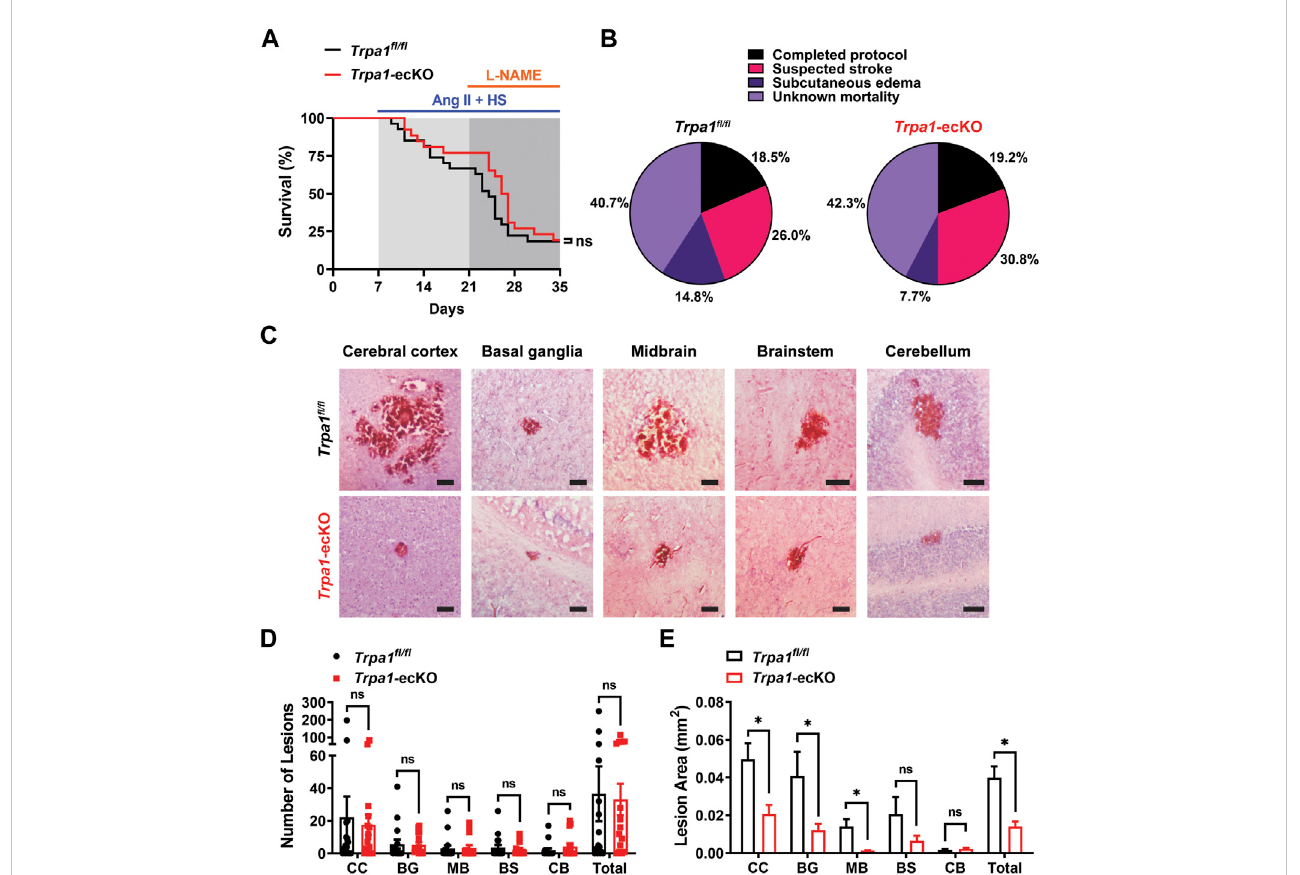
FIGURE 3 Endothelial cell TRPA1 knockout reduces the size of intracerebral hemorrhages during severe hypertension but doesn ’ t improve other outcomes. (A, B) Kaplan-Meier plot (A) and pie charts indicating the distribution of outcomes (B) of Trpa1 fl / fl and Trpa1 -ecKO mice treated with Ang II/HS/L-NAME (n = 27 for controlandn=26for Trpa1 -ecKO,Log-rank(Mantel-Cox)test,ns=notsigni fi cant). (C) RepresentativeimagesofHandEstainedbrainsectionsfrom Trpa1 fl / fl l and Trpa1 -ecKOmice treatedwith AngII/HS/L-NAME. Lesions werefound inthecerebral cortex(CC), basal ganglia(BG),midbrain(MB),brain stem (BS), and cerebellum (CB) in brains of mice from both groups. Scale bar = 100 µm. (D) Summary data showing the number of lesions per brain from Trpa1 fl / fl l and Trpa1 -ecKO mice treated with Ang II/HS/L-NAME (n = 16 for control, n = 15 for Trpa1 -ecKO, unpaired t-test, ns = not signi fi cant). (E) Summary data showing the lesion area in brains from Trpa1 fl / fl l and Trpa1 -ecKO mice treated with Ang II/HS/L-NAME (CC: n = 357 for Trpa1 fl / fl l and n = 265 for Trpa1 -ecKO; BG: n